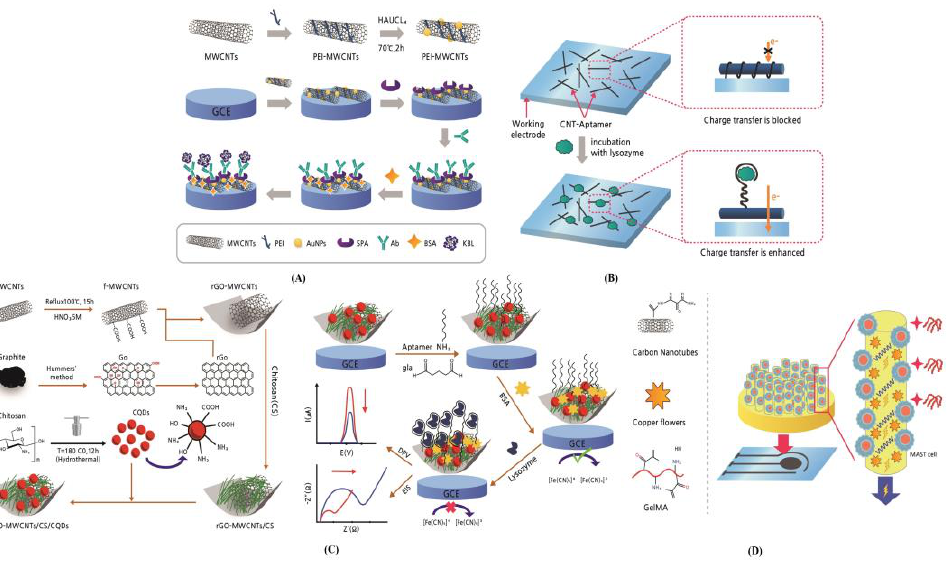
Figure 9. CNT-based biosensors for detecting food allergen proteins. ( A ) An immunosensor modi- fied with AuNPs/MWCNTs/PEI nanocomposite for the allergen assessment of KBL [105]; ( B ) An aptamer-based biosensor using printable ink including a CNT – aptamer complex for the detection of lysozyme [106]; ( C ) An aptamer-based biosensor using GCE/rGO-MWCNT/CS/CQD/APT for the detection of lysozyme [107]; ( D ) A cellular electrochemical biosensor based on FCONp/MWCNT- CDH/GelMA using RBL cell, intestinal microvillus for detecting wheat gliadin, food allergen [108]. The KBL polyclonal antibody, acquired from rabbit immunization, was immobilized on the electrode modified with recombinant staphylococcal protein A via the fragment crystallizable (Fc) region of the antibody. Under the optimized condition, this